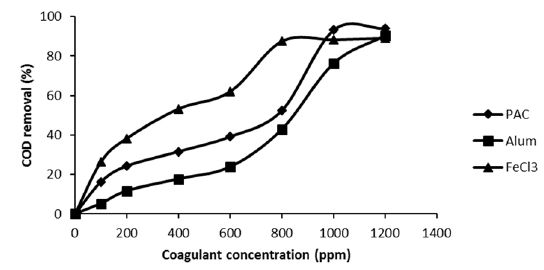
Figure 3. The consequences of the Jar test in the interval of COD removal for different PAC, Alum, FeCl3